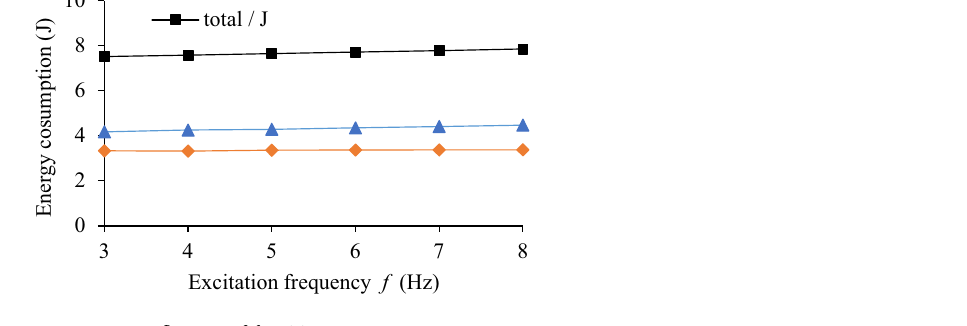
Figure 12. Influence of f on TEC.